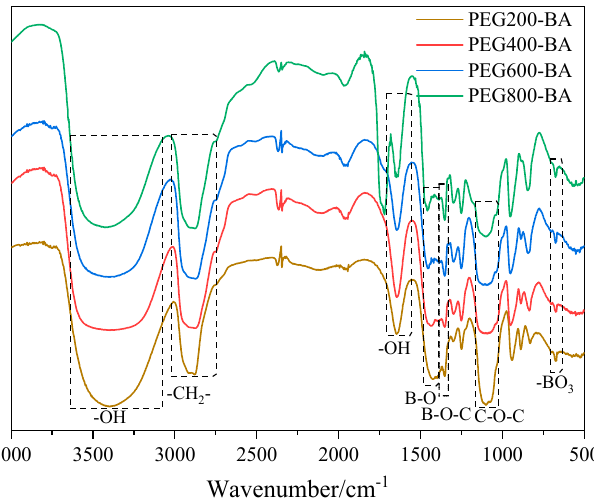
Figure 1. FTIR spectra of PEG-BA with different molecular weights.